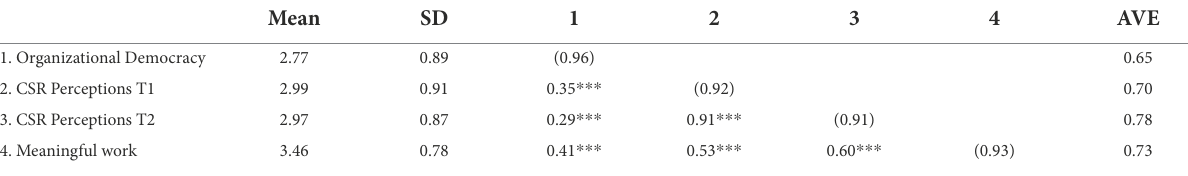
TABLE 1 Descriptive statistics: mean, SD, Pearson’s correlations,